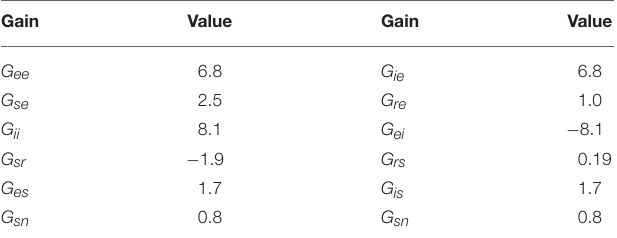
0 and the parameters in Table 1 . =